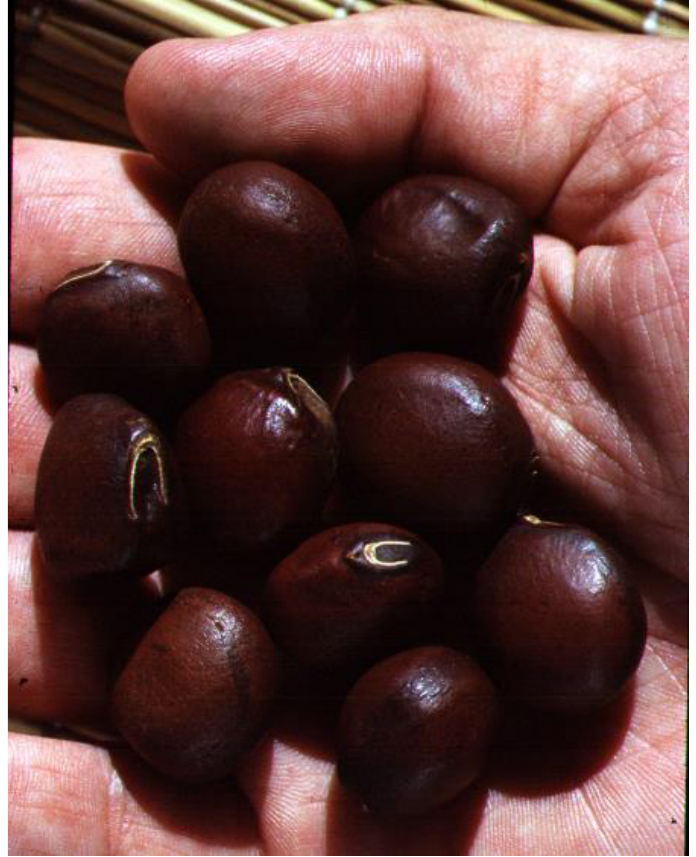
Figure 3. Marama bean ( Tylosema esculentum (Burch.) A.Schreib., (Fabaceae). Image provided by Ben-Erik van Wyk.